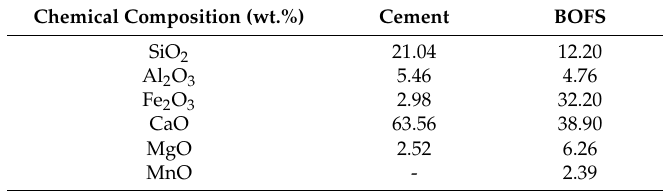
Table 1. Chemical composition of cement and basic oxygen furnace slag